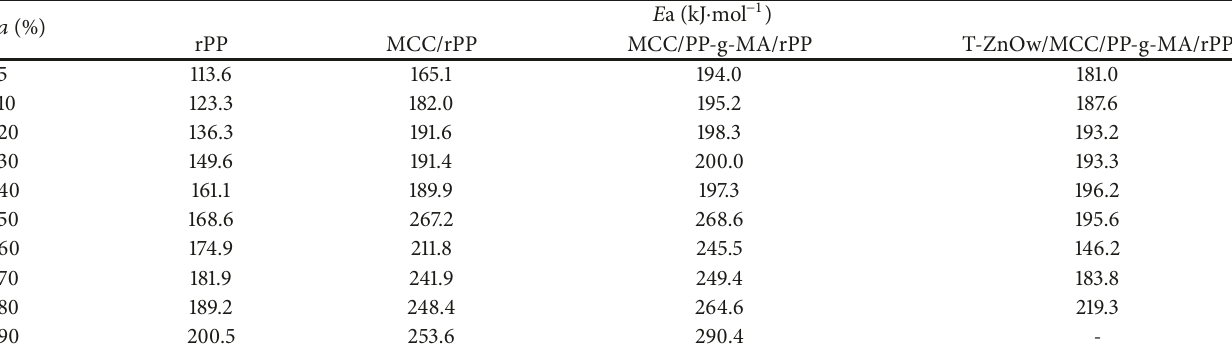
Table 4: E a parameters of rPP and rPP based